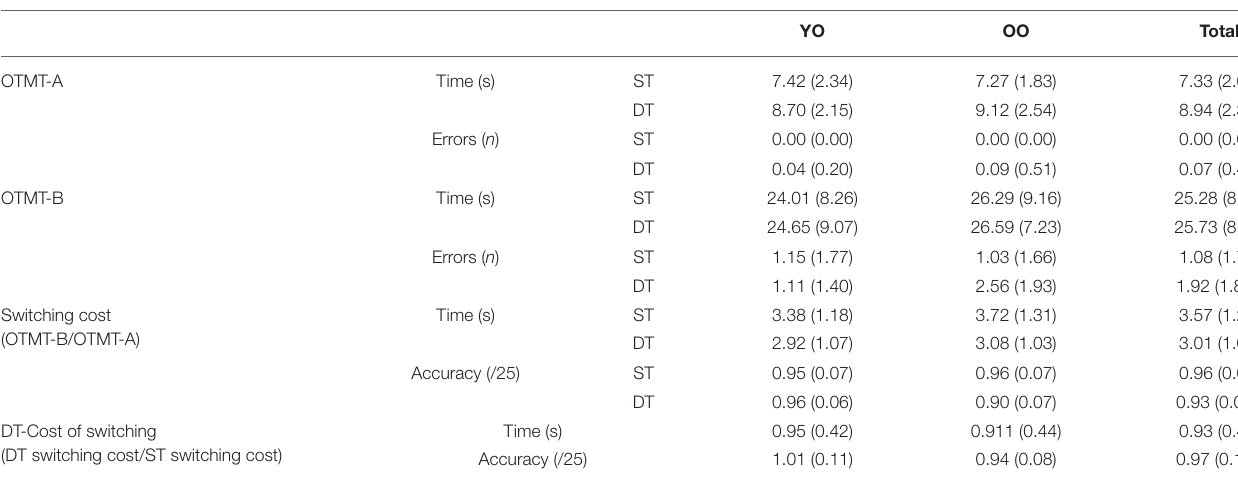
TABLE 3 | Times and scores of the Oral Trail Making Test